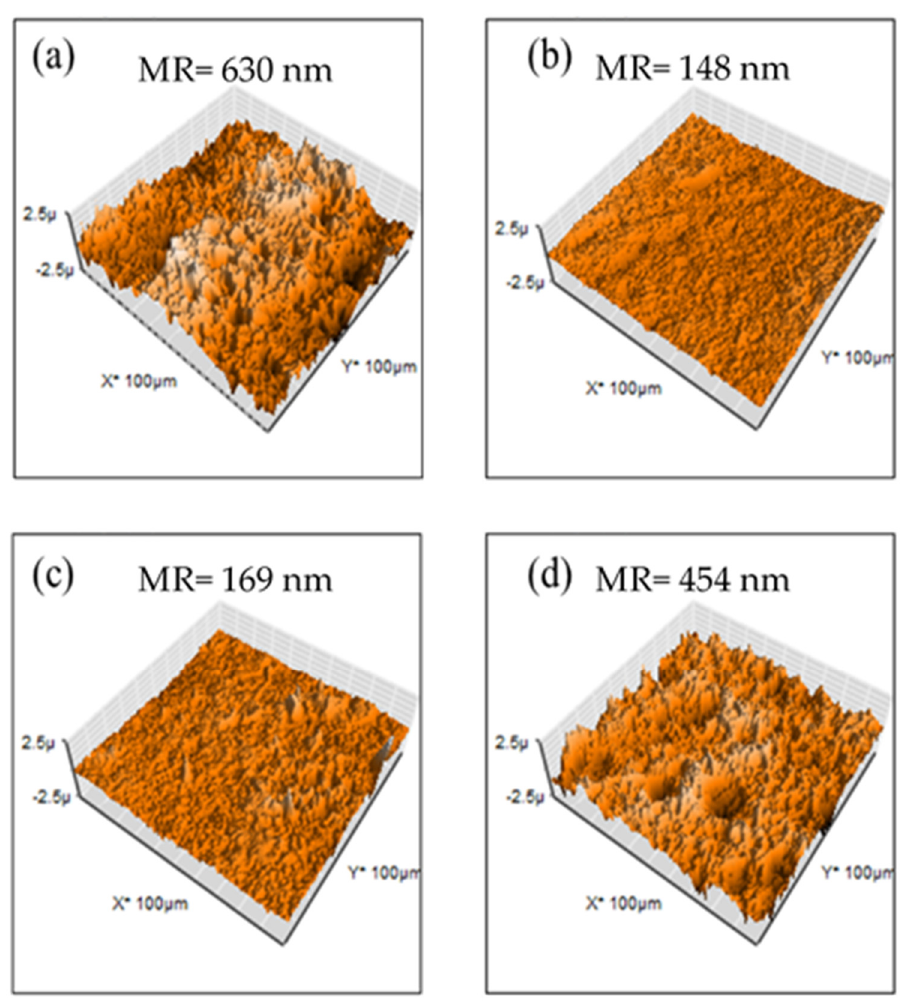
Figure 8. AFM images for PEI-based membranes: ( a ) M1, ( b ) M2, ( c ) M3 y ( d ) M4.